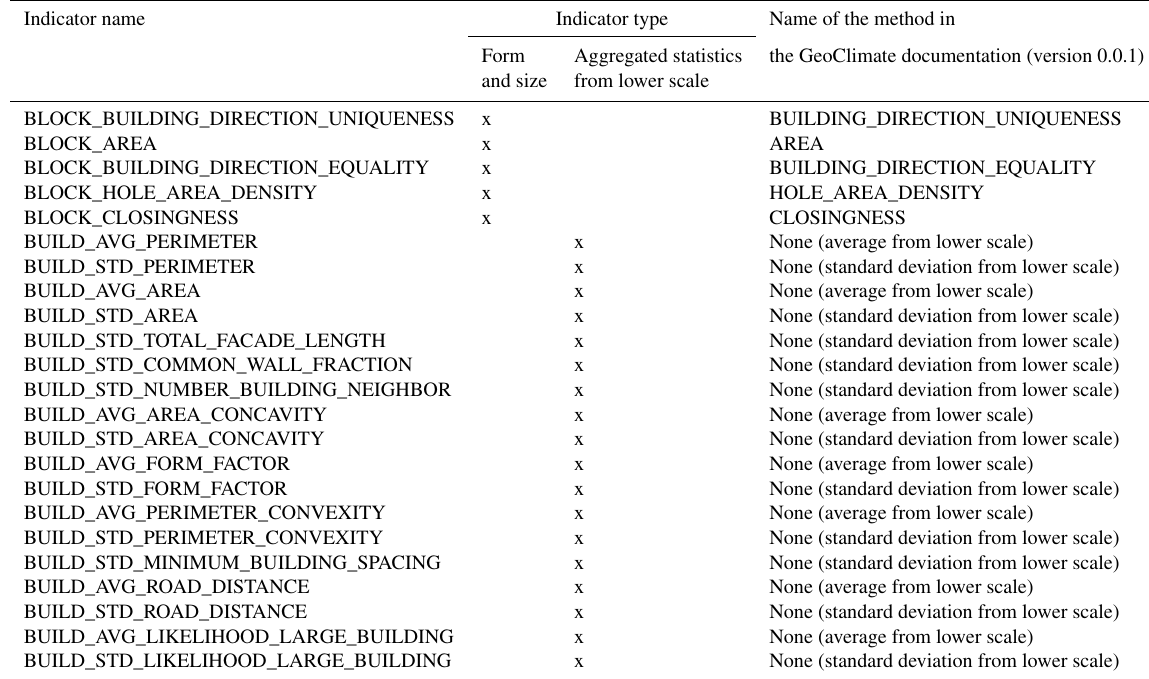
Table A2. List of all block scale spatial indicators used as indepen- dent